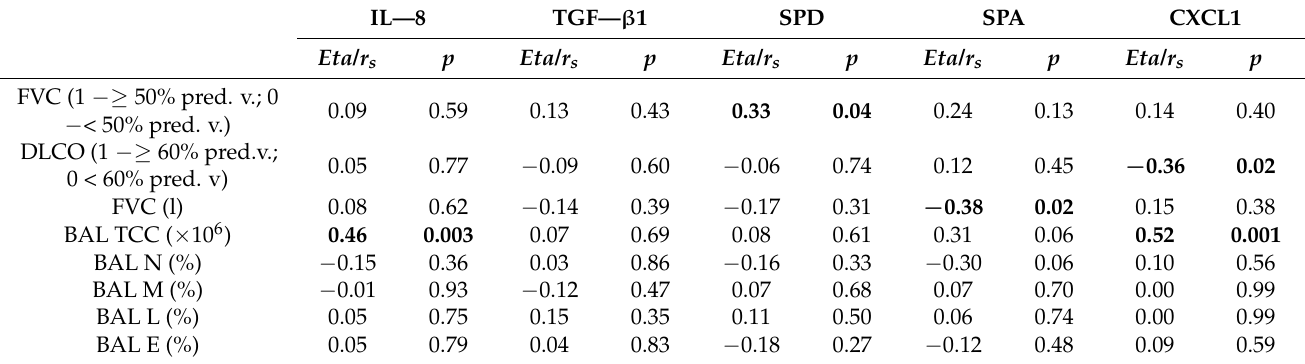
Table 4. Correlation between BAL protein concentrations and pulmonological test parameters.